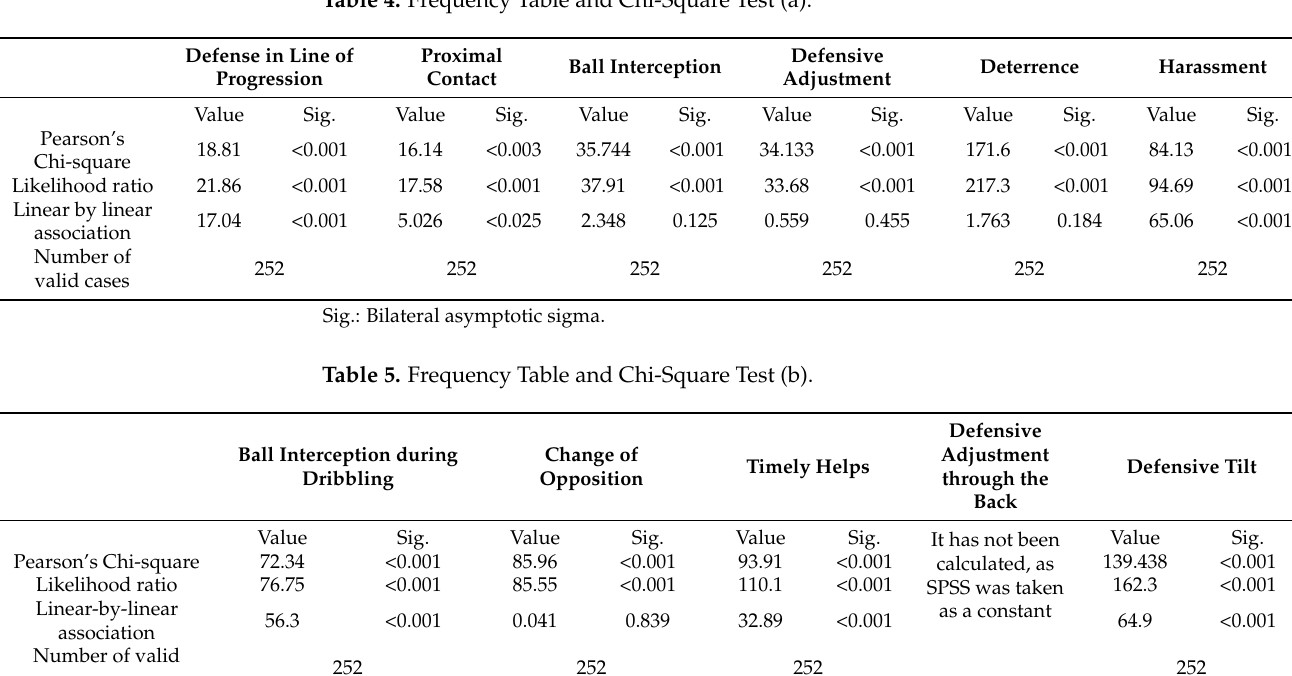
Table 4. Frequency Table and Chi-Square Test (a).